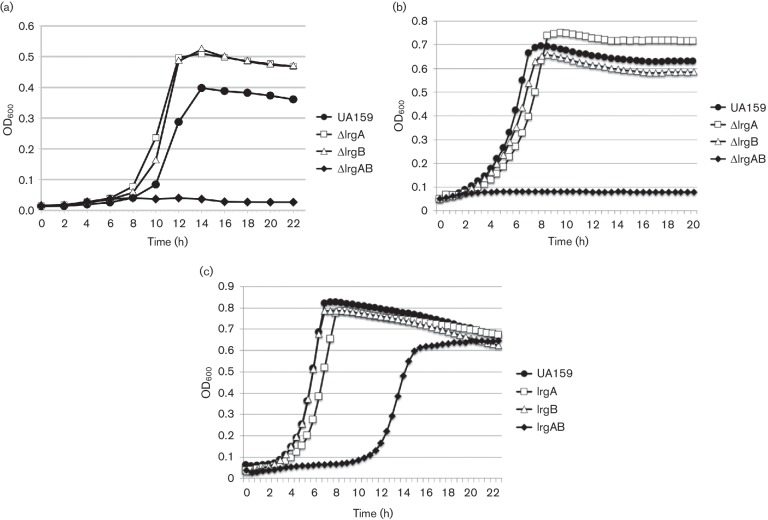
Inhibitory effect of lrgAB mutation on S. mutans growth in the presence of 1 mM H2O2 (a), at 42 °C (b) or in the presence of 1 µg vancomycin ml−1 (c). Growth curves were obtained by growing the wild-type and each indicated mutant in a Biotek plate reader (a) or in a Bioscreen C (b and c), as described in Materials and Methods. Data are representative of n=3 independent experiments.